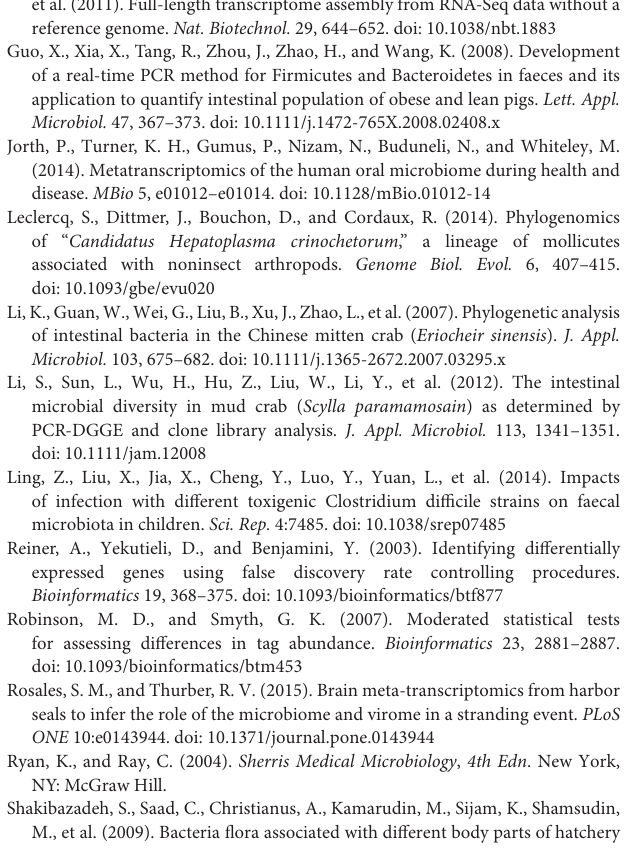
Table S12 | Expression level of five carboxylesterase genes in crabs with and without